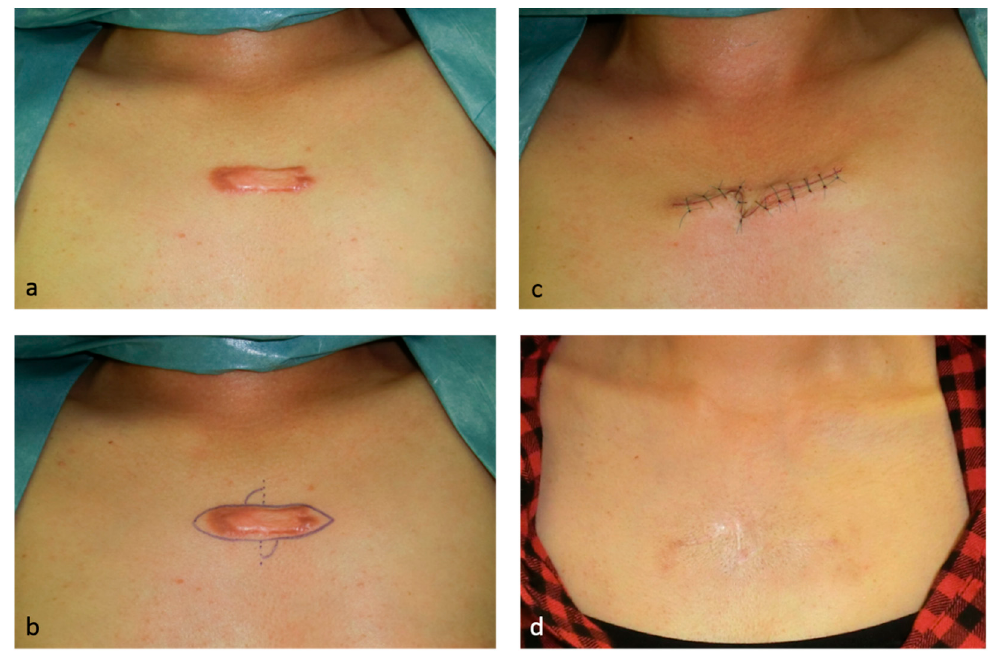
Figure 1. This 24-year-old female had a minor acne keloid on her chest that was treated by surgery, namely, total excision and z-plasty, plus postoperative taping fixation. Since the keloid was small, it could be removed totally and the tension was released by the z-plasty. Immediately after removing the sutures on day 10, silicone tape fixation was started to stabilize the wound. Eighteen months after surgery, recurrence was not observed. ( a ) Preoperative view; ( b ) design of the z-plasty; ( c ) immediately after surgery; and ( d ) 18 months after the operation.